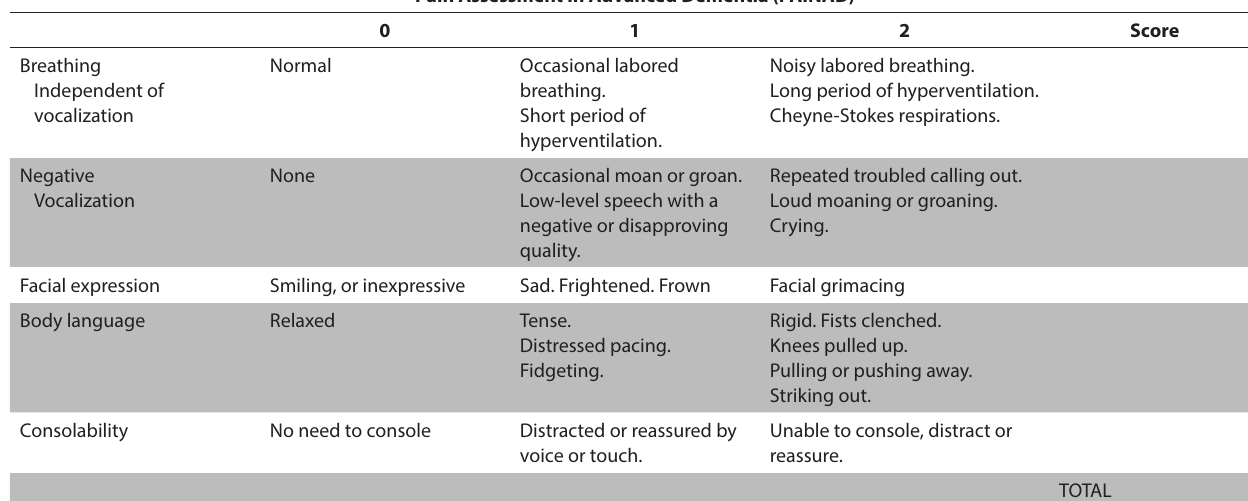
Table 1. PAINAD scale